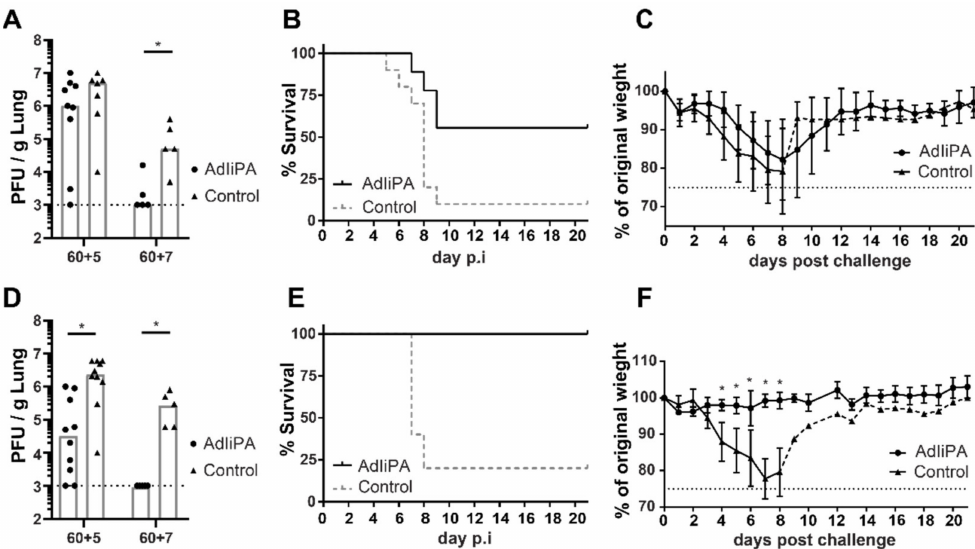
Figure 2. Protection generated by AdIiPA immunization against secondary challenge. C57BL/6 ( A – C ) or BALB/c ( D – F ) mice were immunized with AdIiPA. 60 days later, mice were challenged i.n. with PR8 influenza. For half of the mice, lungs were isolated at days 5 or 7 post-infection to determine viral titers ( A , D ), for remaining mice, survival ( B , E ) and weight loss ( C , F ) was recorded up until 21 days post-challenge. For weight loss and survival, n in graphs for C57BL/6 mice = 5, and n for BALB /c mice = 5. Graphs are representative of experiments repeated three times with similar results. * = p <